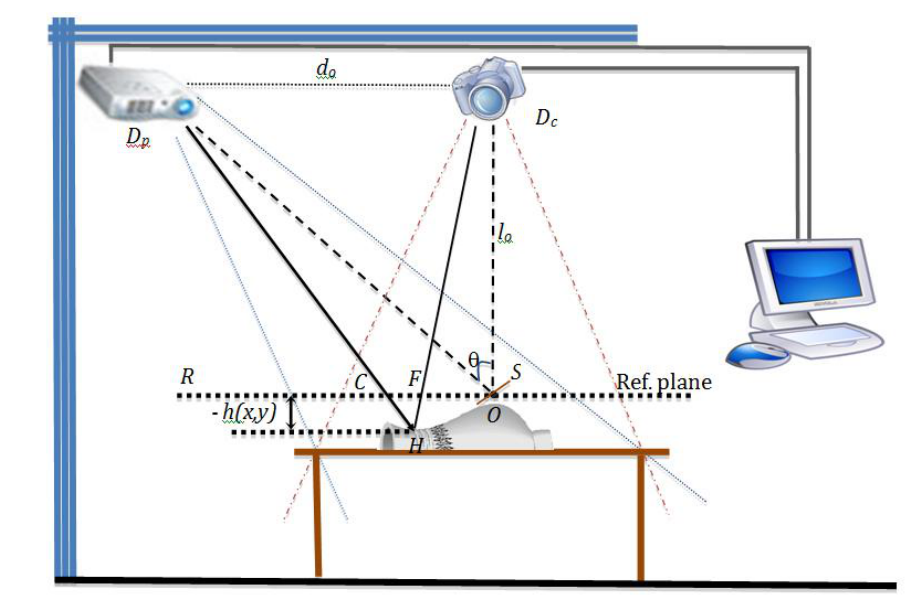
Figure 1. Experimental